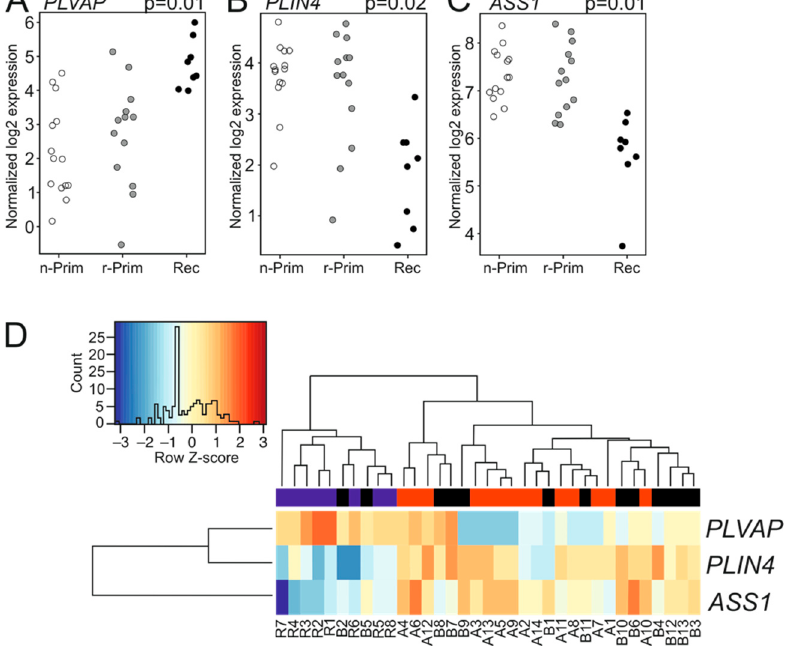
Figure 3. The expression patterns of PLIN4, PLVAP and ASS1 in AGCT samples. The normalized log2 expression values for PLVAP ( A ), PLIN4 ( B ), and ASS1 ( C ) were plotted for each sample and group. White circle represents the n-Prim, grey circle represents the r-Prim, and black circles represent the Rec samples, respectively. Differences in transcript abundance are shown for PLVAP, PLIN4, and ASS1 in AGCT samples ( D ). In the heatmap, red color represents relative increase in abundance; the blue color represents relative decrease, and the white color represents no change. The red color in the bar above the heatmap represents n-Prim, the black color represents the r-Prim, and the blue color represents Rec samples, respectively.